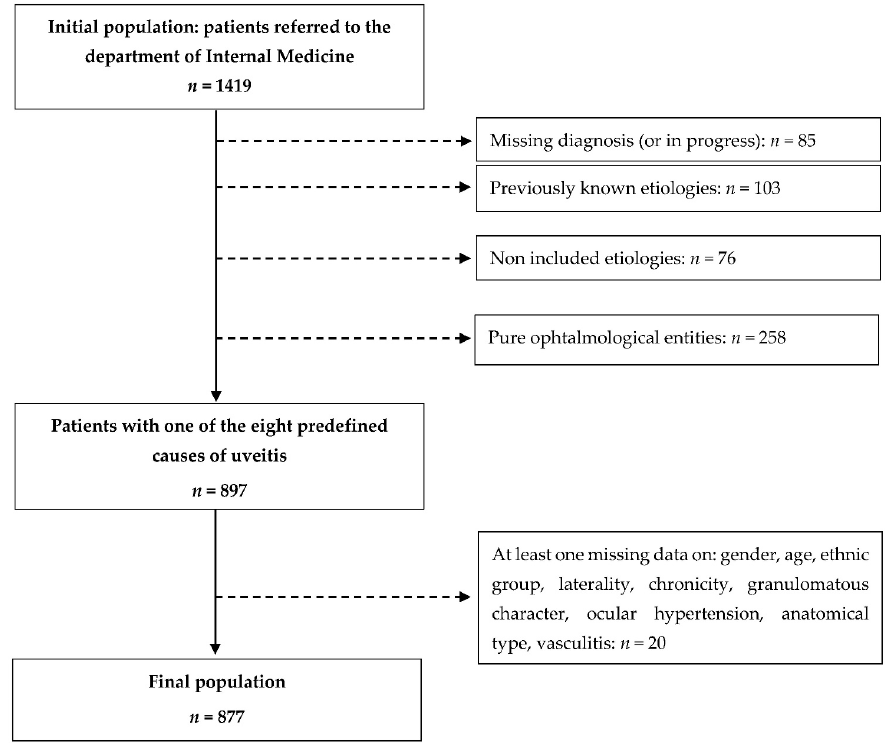
Figure 1. Flow chart for the training dataset.